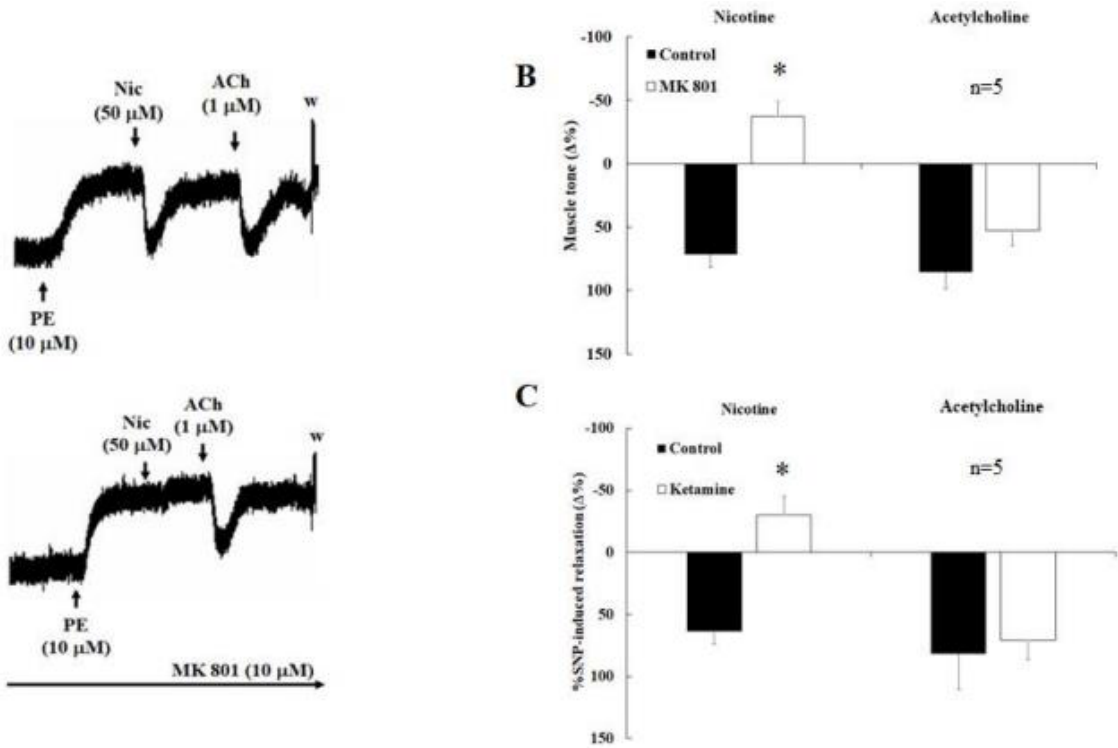
Figure 3. Effect of MK-801 and ketamine on corpus cavernosum relaxation . The representative tracing in ( A ) shows that the corpus cavernosum (CC) was precontracted by phenylephrine (PE, 10 μM). ( B ) Nicotine (Nic, 50 μM) induced CC relaxation, which was inhibited by MK-801 (10 μM) but not acetylcholine (ACh, 10 μM). ( C ) Summary data showing the effects of MK-801 on CC strips ( n = 5, p < 0.05). The relaxation response induced by nicotine (50 μM) was inhibited by ketamine (10 μM, n = 5, p < 0.05). The ACh- and nicotine-induced CC smooth muscle relaxation were estimated as a percentage of sodium nitroprusside (SNP, 0.1 mM)-induced maximum relaxation. n , number of experiments. Values are means ± SD. Asterisks indicate a significant difference in the paired t -test (* p < 0.05) vs. the control group.